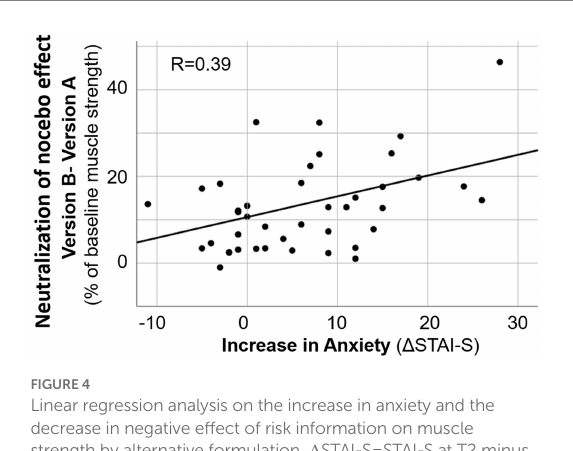
FIGURE 4 Linear regression analysis on the increase in anxiety and the decrease in negative effect of risk information on muscle strength by alternative formulation. Δ STAI-S = STAI-S at T2 minus STAI-S at